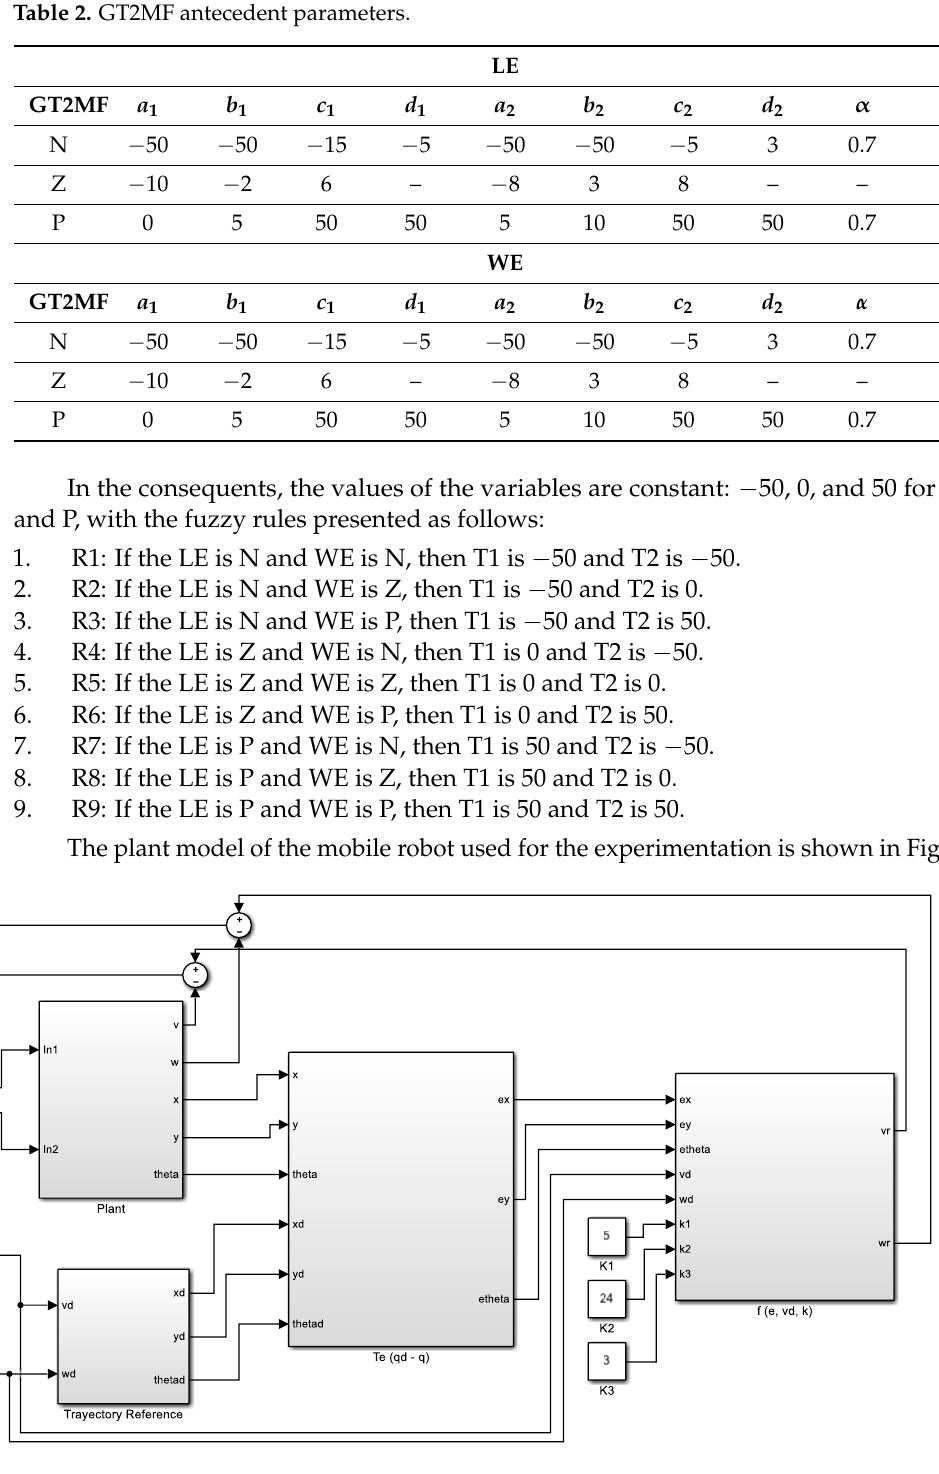
Table 3. Types of disturbances applied to the controller. Disturbance Number